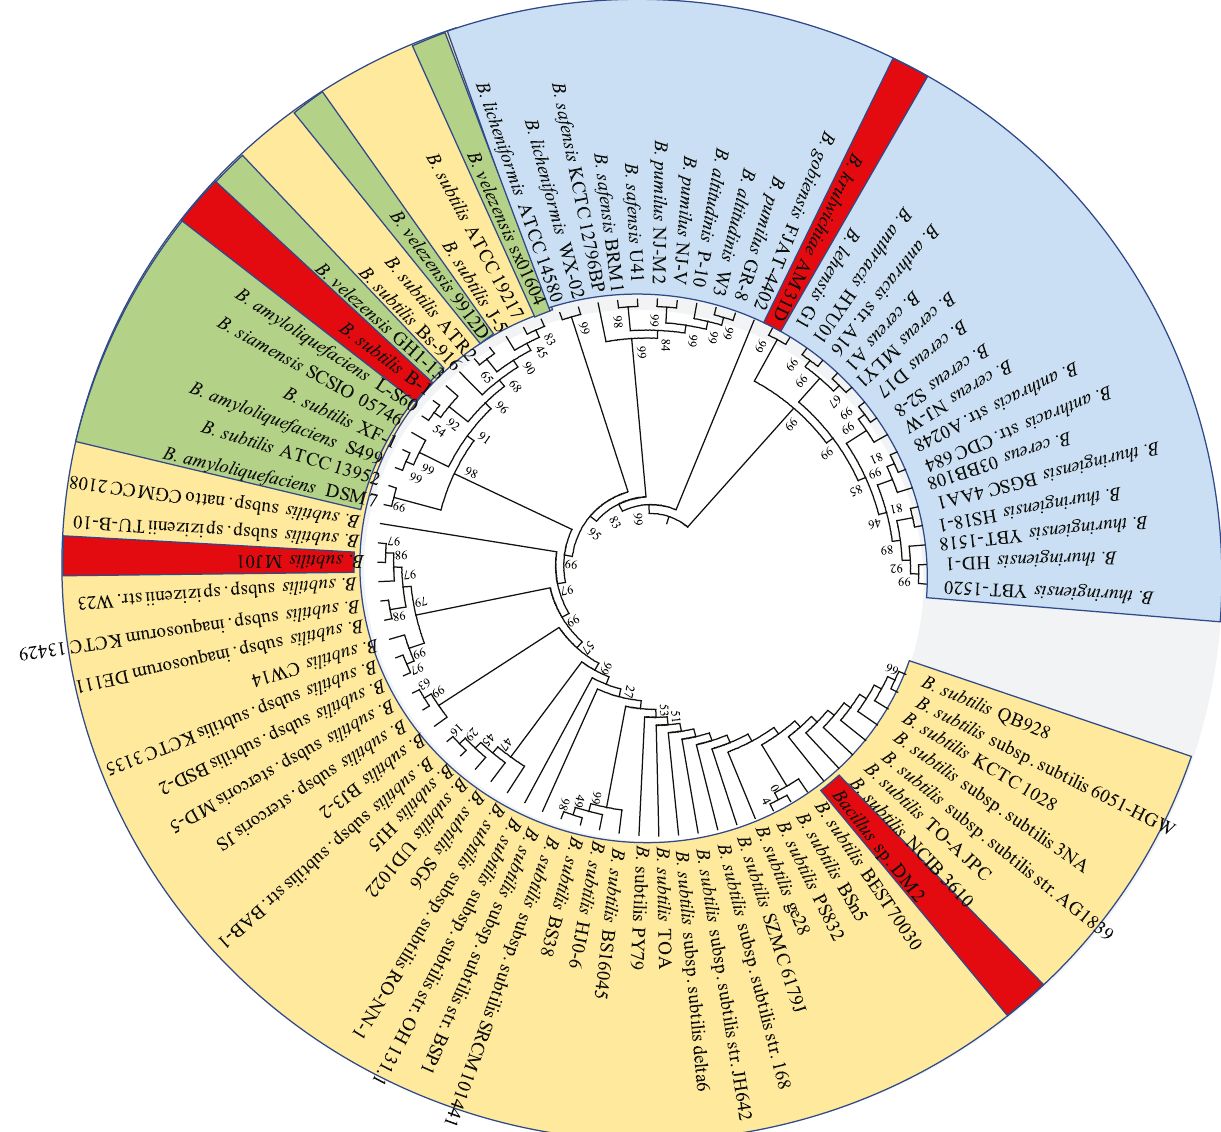
Figure 4: Neighbor-joining phylogenetic tree based on the protein sequences of 24 housekeeping genes of the Bacillaceae family members. The members of B. subtilis (orange-colored), outgroups of B. subtilis (blue-colored), the members of B. velezensis and B. amyloliquefaciens (green-colored), and the isolates from the crude-oil environment (red-colored) are